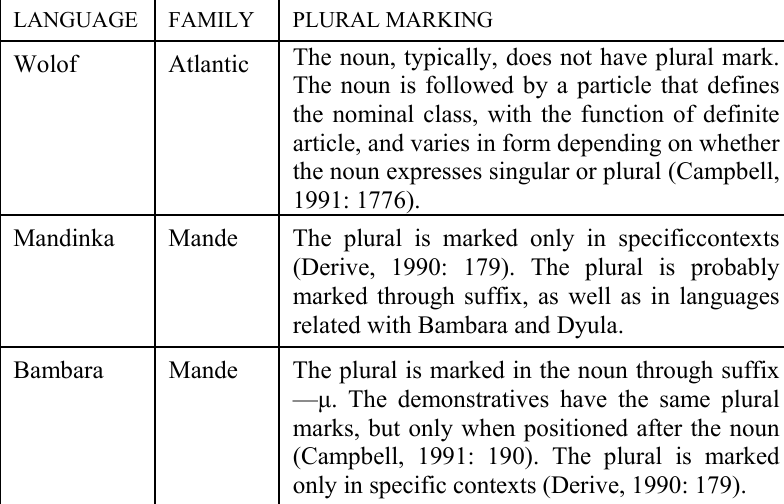
Table X. Plural marking in Cape Verdean Creole substrates LANGUAGE